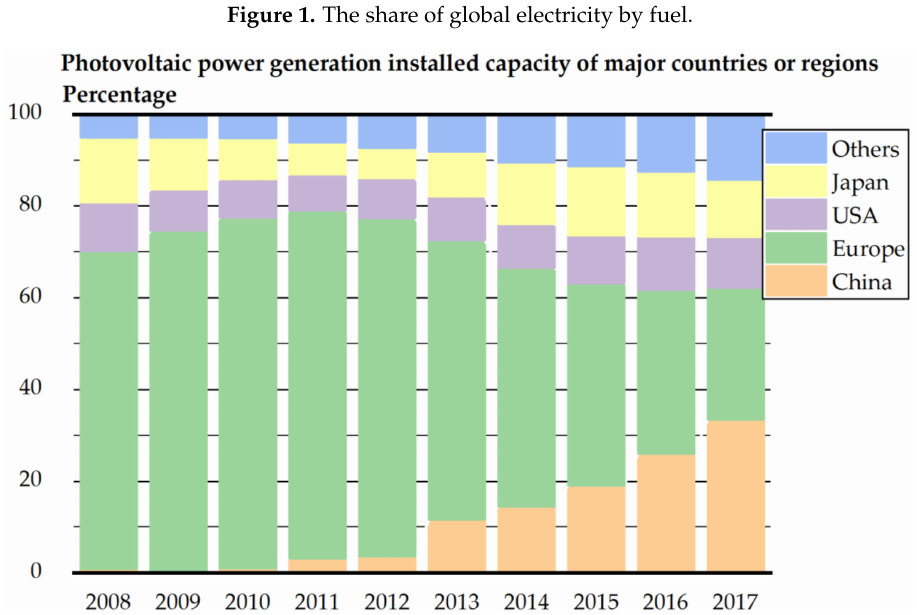
Figure 1. The share of global electricity by fuel.